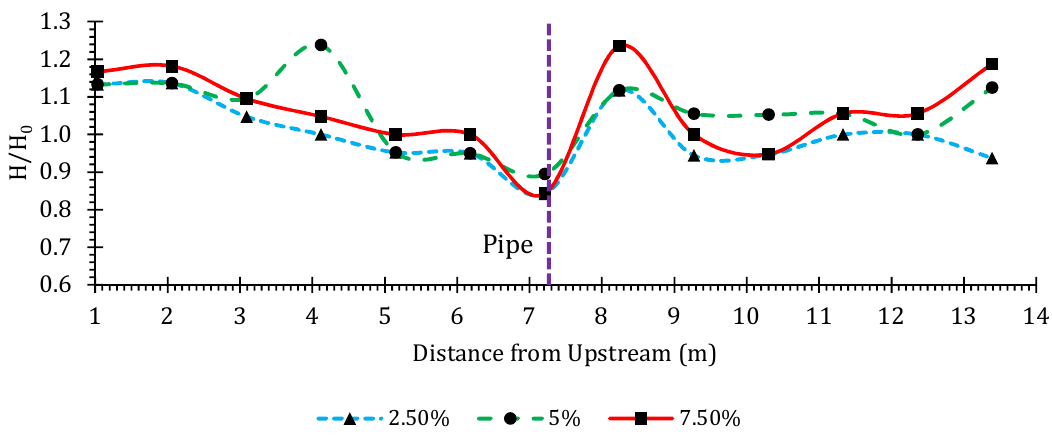
Figure A38. Water height ratios in a 45 ◦ junction for Fr = 2.32 in the narrow Figure A38. Water height ratios in a 45° junction for Fr = 2.32 in the narrow channel. Figure A38. Water height ratios in a 45° junction for Fr = 2.32 in the narrow channel. Figure A38. Water height ratios in a 45° junction for Fr = 2.32 in the narrow channel.